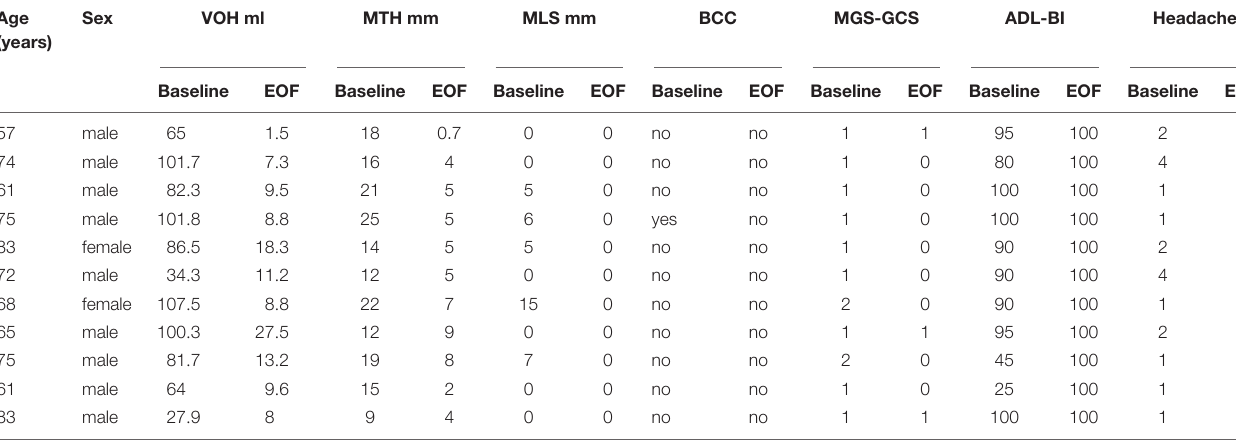
TABLE 3 | Information of patients with visible CSDH at the end of follow up.